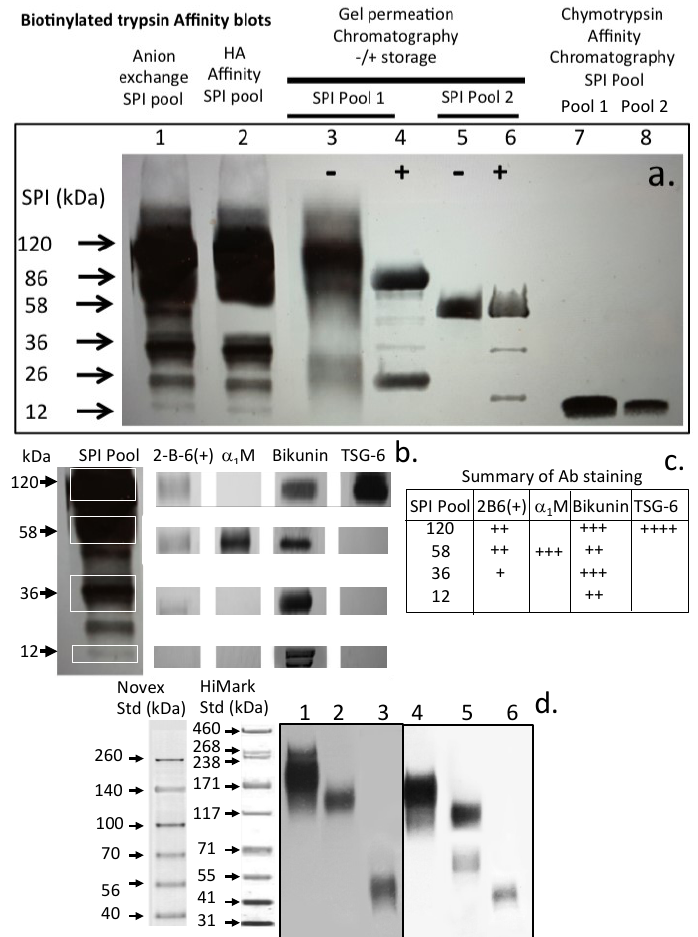
Figure 6. Identification of serine proteinase inhibitor (SPI) species using biotinylated trypsin and avidin alkaline phosphatase conjugate by affinity blotting in samples from the various isolation procedures used in this study ( a ) Selected bands were also identified using antibodies to CS (2-B-6 (+)), α 1 M, Bikunin, and TSG-6 ( b ) and the blot intensities summarized in the Table in ( c ). ITI and pre- α -TI present in ovine plasma (lanes 1, 2, 4, 5) and UTI in urine (lanes 3, 6) were also identified by Western blotting using antibodies to ITI (lanes 1, 2) and bikunin (lane 3) and by affinity blotting using bT (lanes 4–6) ( d ). The extra band in lane 5 but not in lane 2 in segment ( d ) is due to α 1-proteinase inhibitor which also displays an affinity for HA thus is also included in the pre- α -TI pool taken from Sephadex G200 chromatography in our isolation scheme.